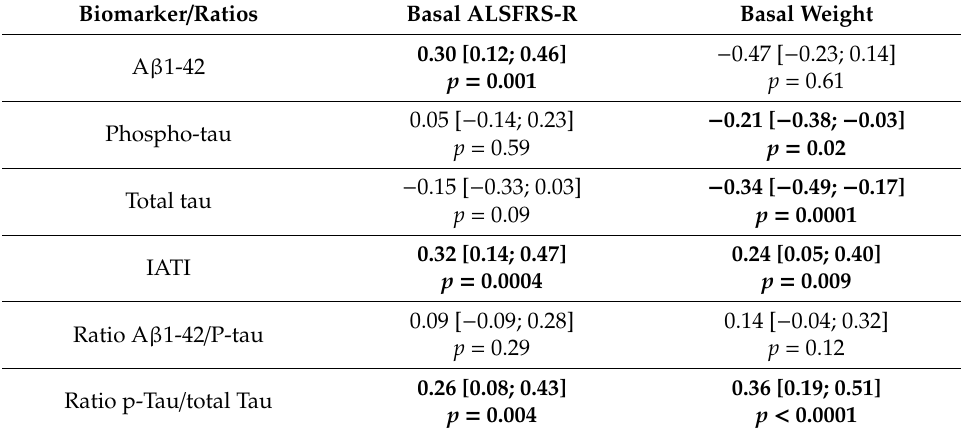
Table 3. Correlation between biomarkers and ALS clinical parameters at